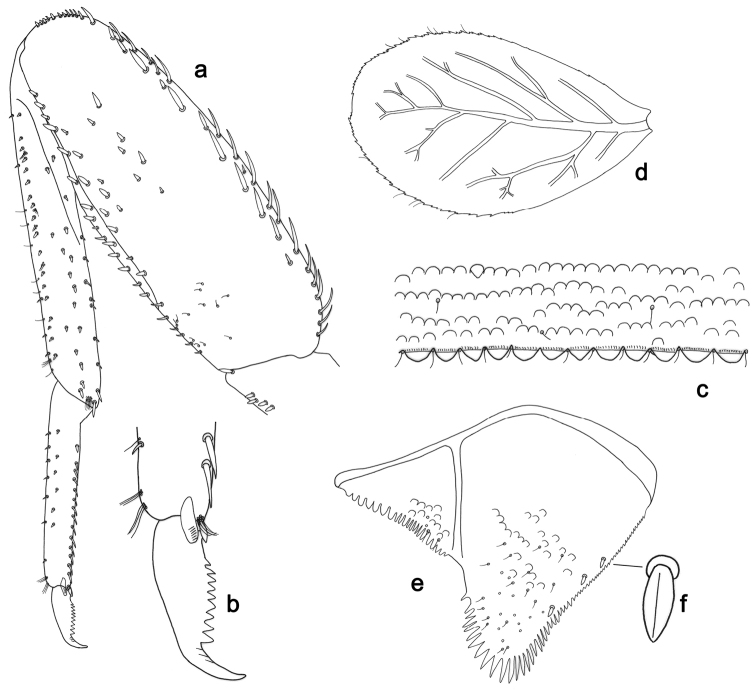
Labiobaetispodolakae sp. n., larva morphology: aForelegb Fore claw cTergum IV d Gill IV eParaproctf Seta near paraproct margin.